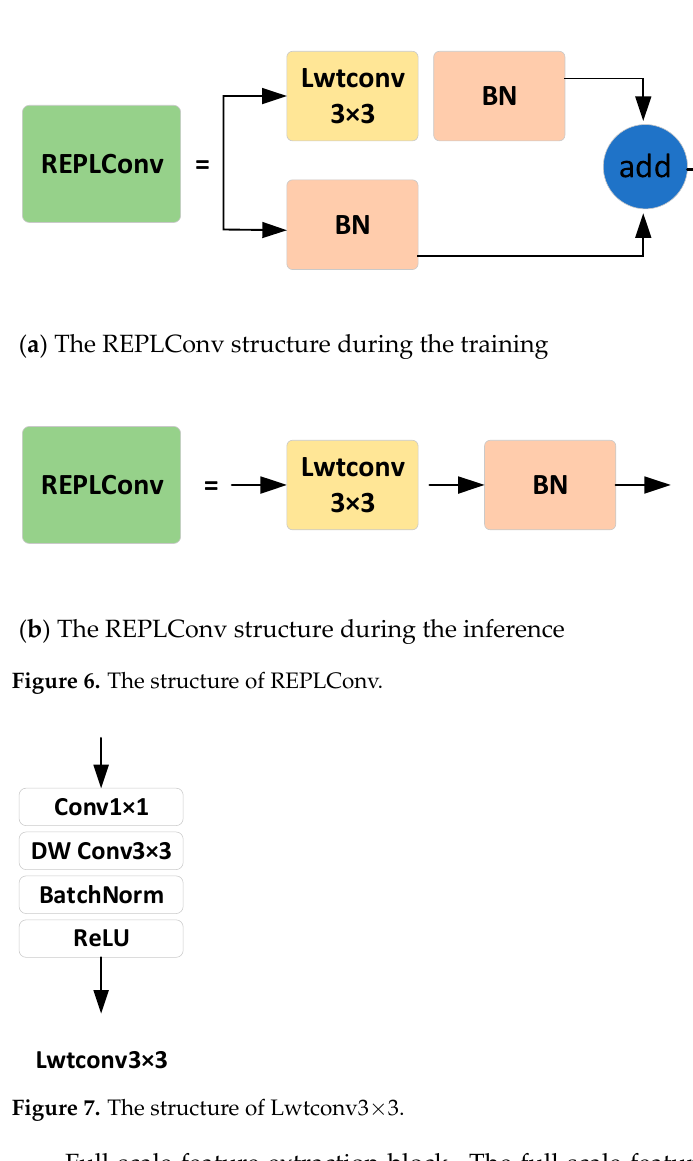
Figure 7. The structure of Lwtconv3×3.